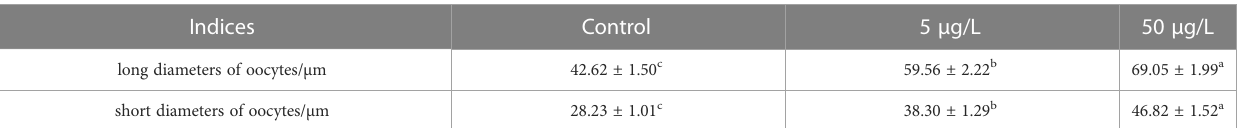
TABLE 2 The oocytes diameters of C. sinensis in different estradiol treatment.